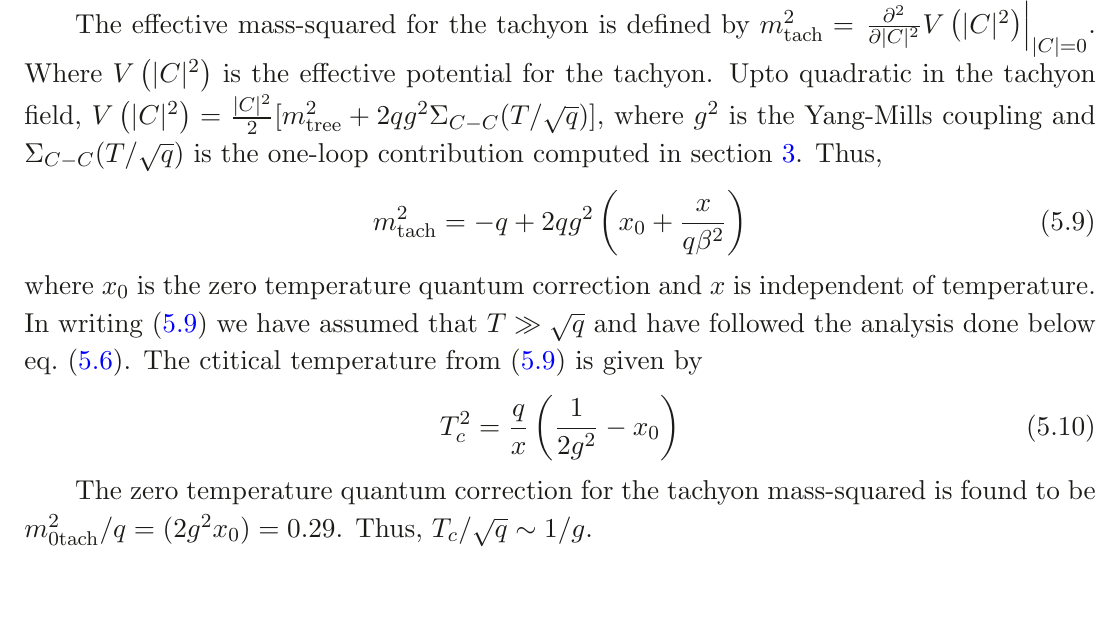
/q vs √ qβ . Figure 24 . Plot of m 2 tach